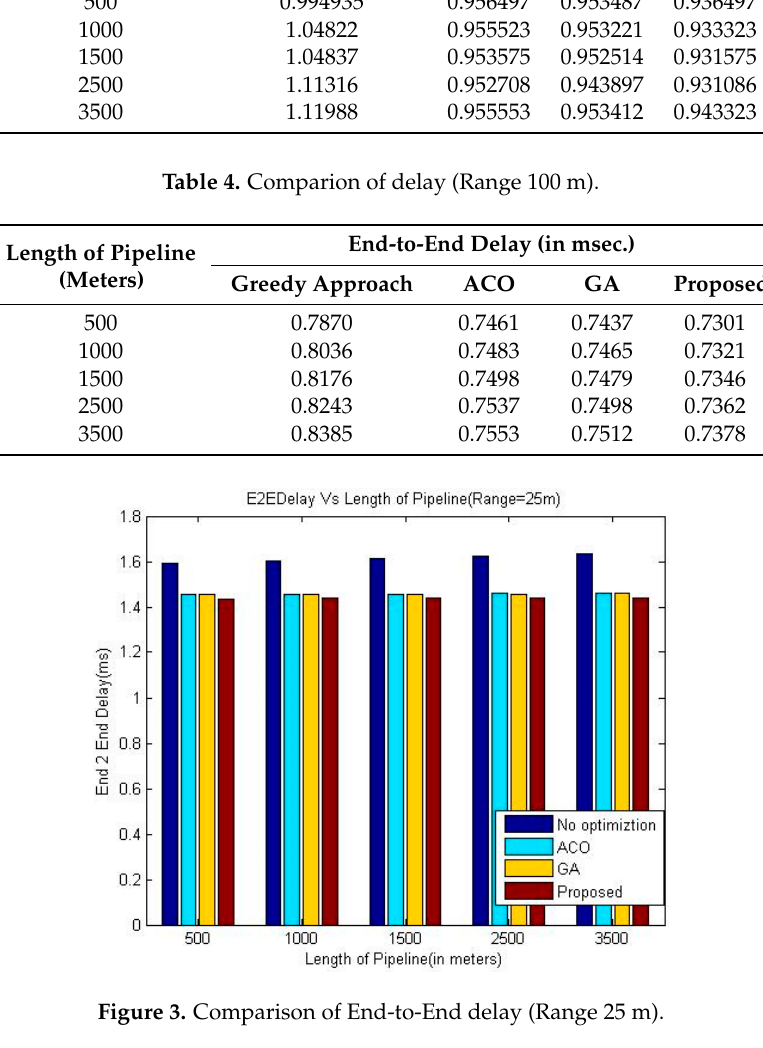
Figure 4. Comparison of End-to-End delay (Range 50 m). Figure 5. Comparison of End-to-End delay (Range100 m).